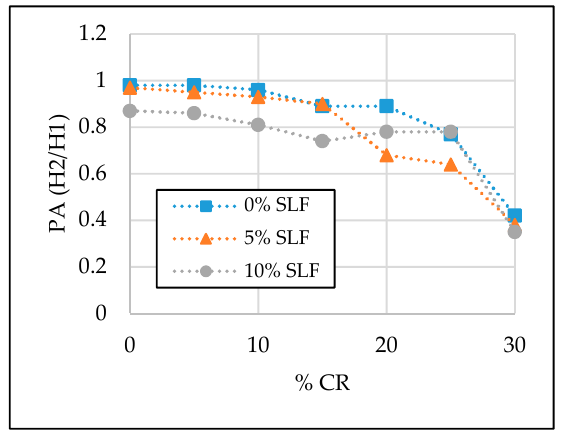
ff ect of crumb rubber and silica fume on L-box values (PA = H Figure 10. The effect of crumb rubber and silica fume on L-box values (PA = H 2 /H 1 ). Figure 10. The e